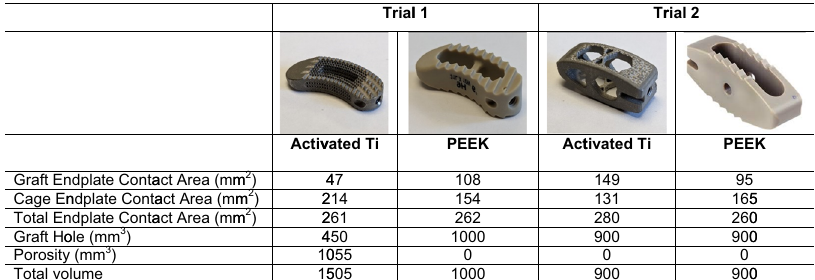
Fig. 1 Pictures of Activated Ti and PEEK interbody cages used in Trial 1 and 2 (left and right) along with their respective surface contact characteristics. For Trial 1, considering 34 mm length × 10 mm width (6° lordotic) Ti and PEEK implants, comparable graft and cage